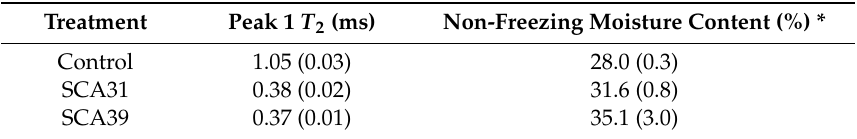
Table 4. Peak maximum T 2 values and non-freezing moisture content for control, 31% sorbitol citric acid and 39% sorbitol citric acid modified samples measured at − 22 ◦ C. Standard deviation of four replicates in